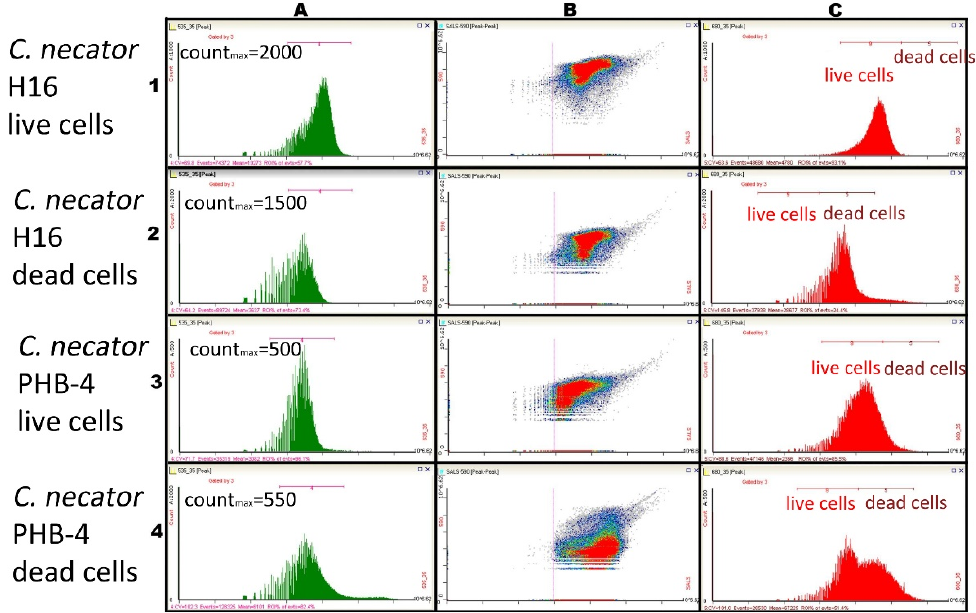
Figure 6. Autofluorescence of cells ( A ); scattergram of the culture ( B ); live/dead cells dyed with propidium iodide ( C ); Cupriavidus necator H16 live cells—autofluorescence count maximum 2000 (1); Cupriavidus necator PHB-4 live cells—autofluorescence count maximum 1500 (2); Cupriavidus necator H16 dead cells—autofluorescence count maximum 500 (3); Cupriavidus necator PHB-4 dead cells—autofluorescence count maximum 550 (4).